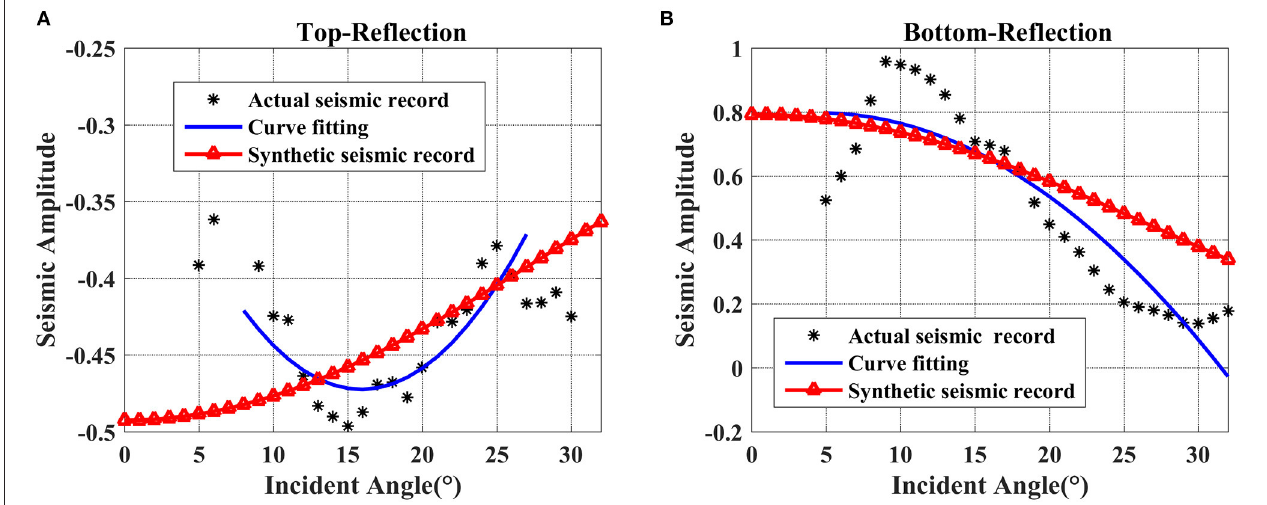
FIGURE 14 | AVO characteristics analysis of the top and bottom reflection events picked from the well-side seismic records and synthetic seismic records. (A) Top reflection, (B) bottom reflection.